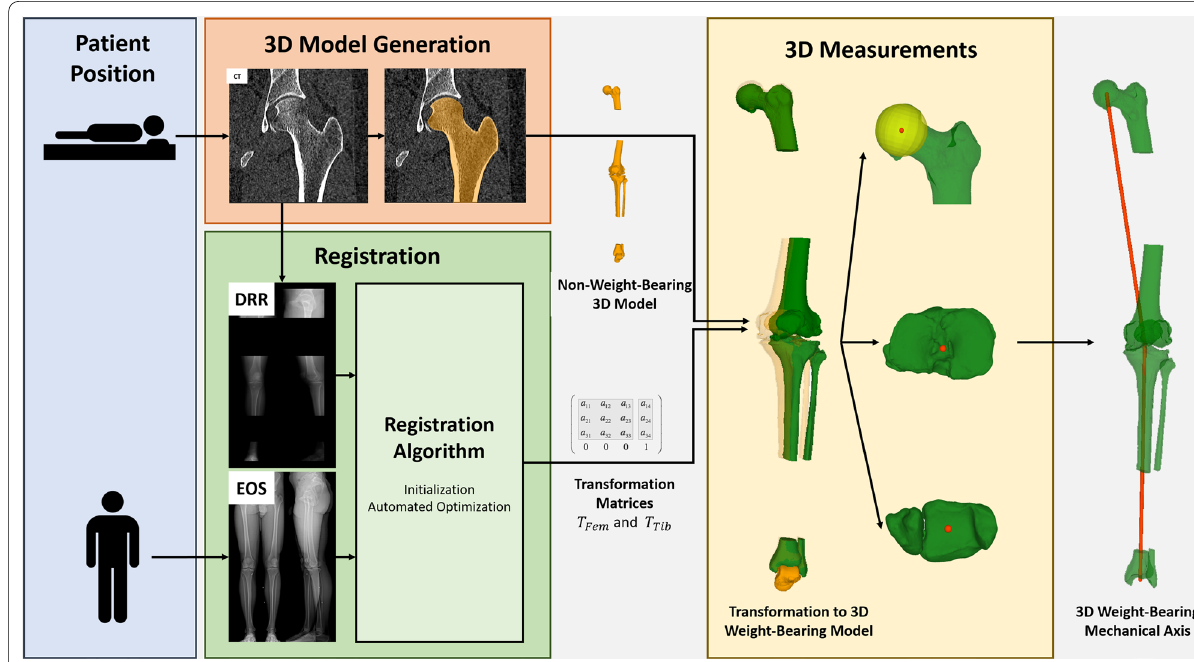
Fig. 1 Registration and measurement pipeline for the 3D preoperative planning of corrective osteotomies under weight-bearing conditions. CT scans of the hip, knee and ankle joints as well as biplanar EOS images are required as an input for the pipeline. MA and JLCA assessed in a weight-bearing position are the